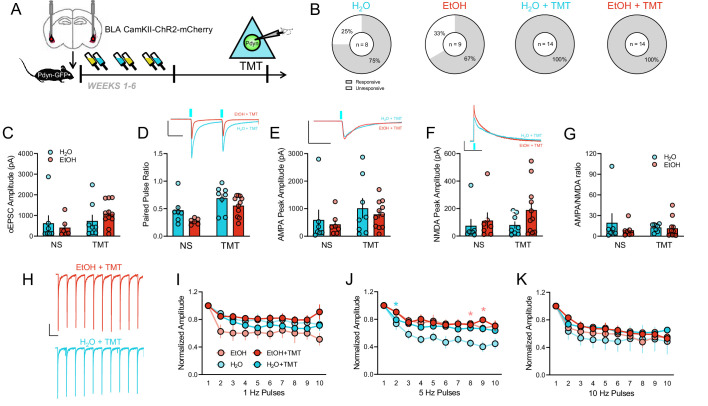
Basolateral amygdala input onto BNSTPDYN cells after history of alcohol and TMT exposure.(A) Experimental design testing synaptic connectivity of basolateral amygdala (BLA) input to BNSTPDYN cells using channelrhodopsin (ChR2) after EtOH and TMT. (B) Proportions of light-responsive (white) and non-light-responsive (grey) BNSTPDYN cells to optically-evoked EPSC in H2O (6/8 responsive cells, n = 3), EtOH (6/9 responsive cells, n = 4), H2O + TMT (14/14 responsive cells, n = 4), and EtOH + TMT (14/14 responsive cells, n = 4) groups. (C) BLA-BNSTPDYN oEPSC amplitude (pA). (D) Paired pulse ratio. Inset example traces of H2O + TMT (aqua) and EtOH + TMT (red) with blue LED onset. Scale bar indicates 500 pA height and 50 ms time. (E) AMPA peak amplitude (pA). Inset AMPA traces of H2O + TMT (aqua) and EtOH + TMT (red) with blue LED onset. Scale bar indicates 1000 pA height and 50 ms time. (F) NMDA peak amplitude (pA). Inset NMDA traces of H2O + TMT (aqua) and EtOH + TMT (red) with blue LED onset. Scale bar indicates 200 pA height and 500 ms time. (G) AMPA/NMDA ratio. (H) Representative traces of 1 Hz pulse trains in EtOH + TMT (red) and H2O + TMT (aqua) BNSTPDYN cells. Scale bar indicates 200 pA height and 1 s time. oEPSC normalized amplitude across (I) 1 Hz, (J) 5 Hz, and (K) 10 Hz pulse trains. *p<0.05.